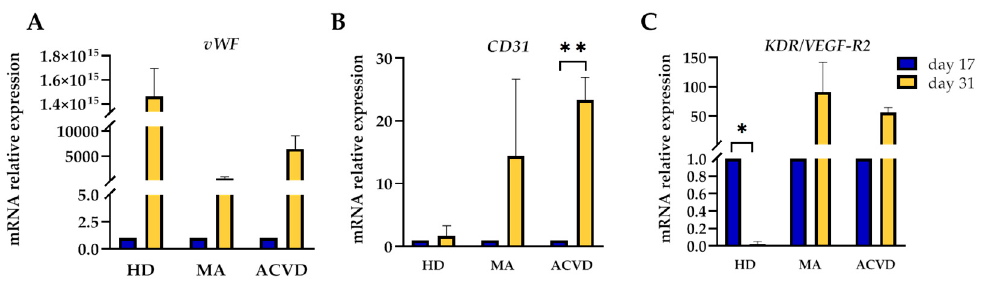
Figure 4. mRNA relative expression of ( A ) von Willebrand Factor ( vWF) , ( B ) CD31 , and ( C ) KDR/ Vascular endothelial growth factor-receptor2 ( VEGF-R2) in EPCs at 17 and 31 days after seeding: the mRNA levels in EPCs at day 31 from HD, MA, and ACVD subjects are expressed in relation to EPCs at day 17, arbitrarily imposed at 1 as calibrator. β 2-microglobulin ( β 2M ) was used as housekeeping gene. Data were expressed as mean ± SD, and statistical significance (* p < 0.05, ** p < 0.01) was calculated through Student’s t -test. Values of at least three independent experiments are shown.